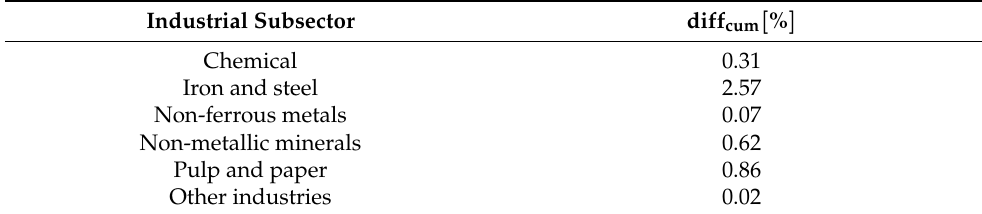
Table 4. Average relative difference between TIMES-Italy and TEMOA-Italy results in cumulative activity for industrial technologies.